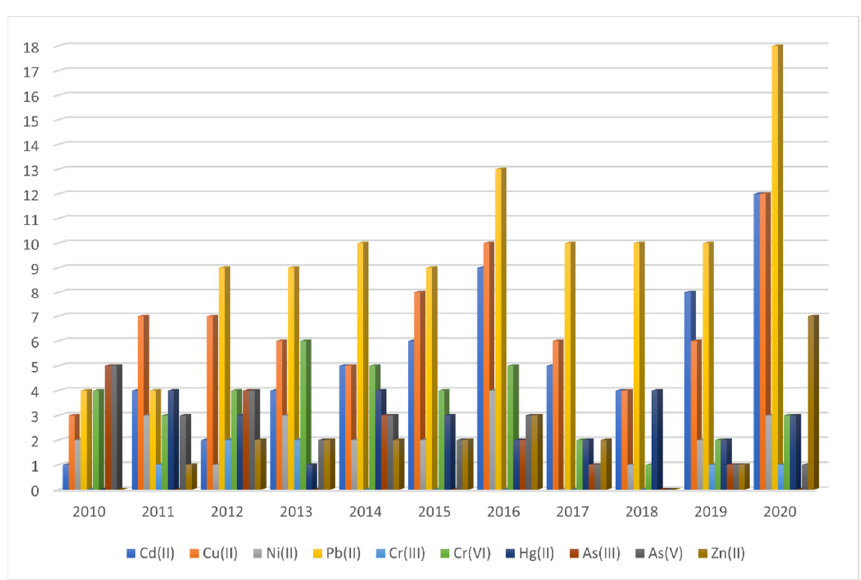
Figure 2. Selection of research articles per year.